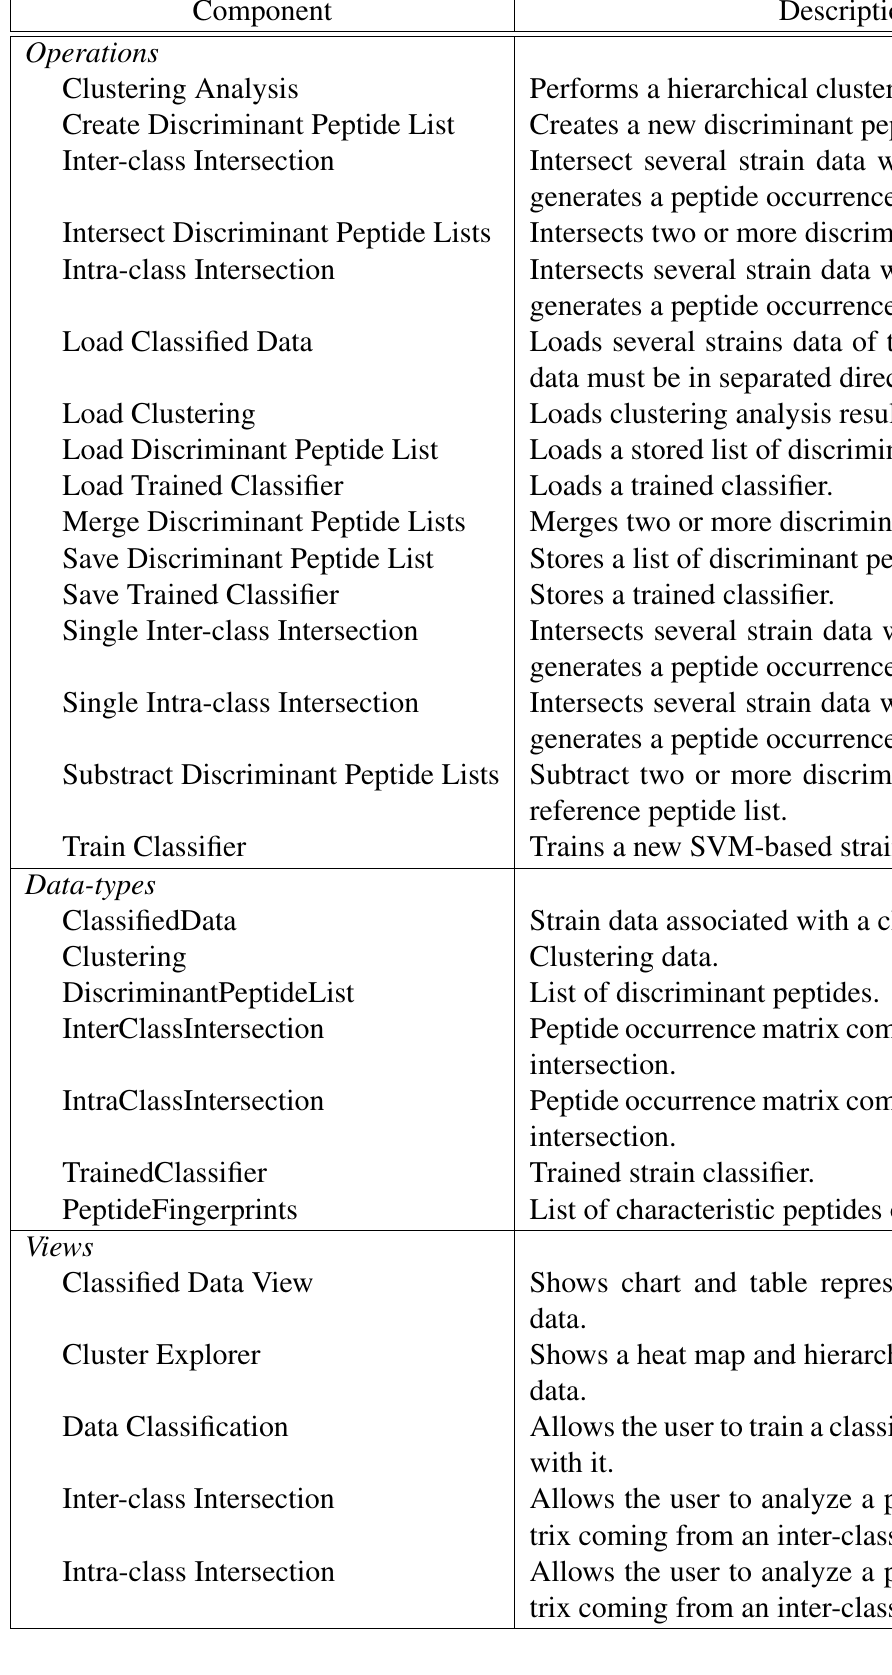
Table 2: AIBench components of the Bacterial Identification